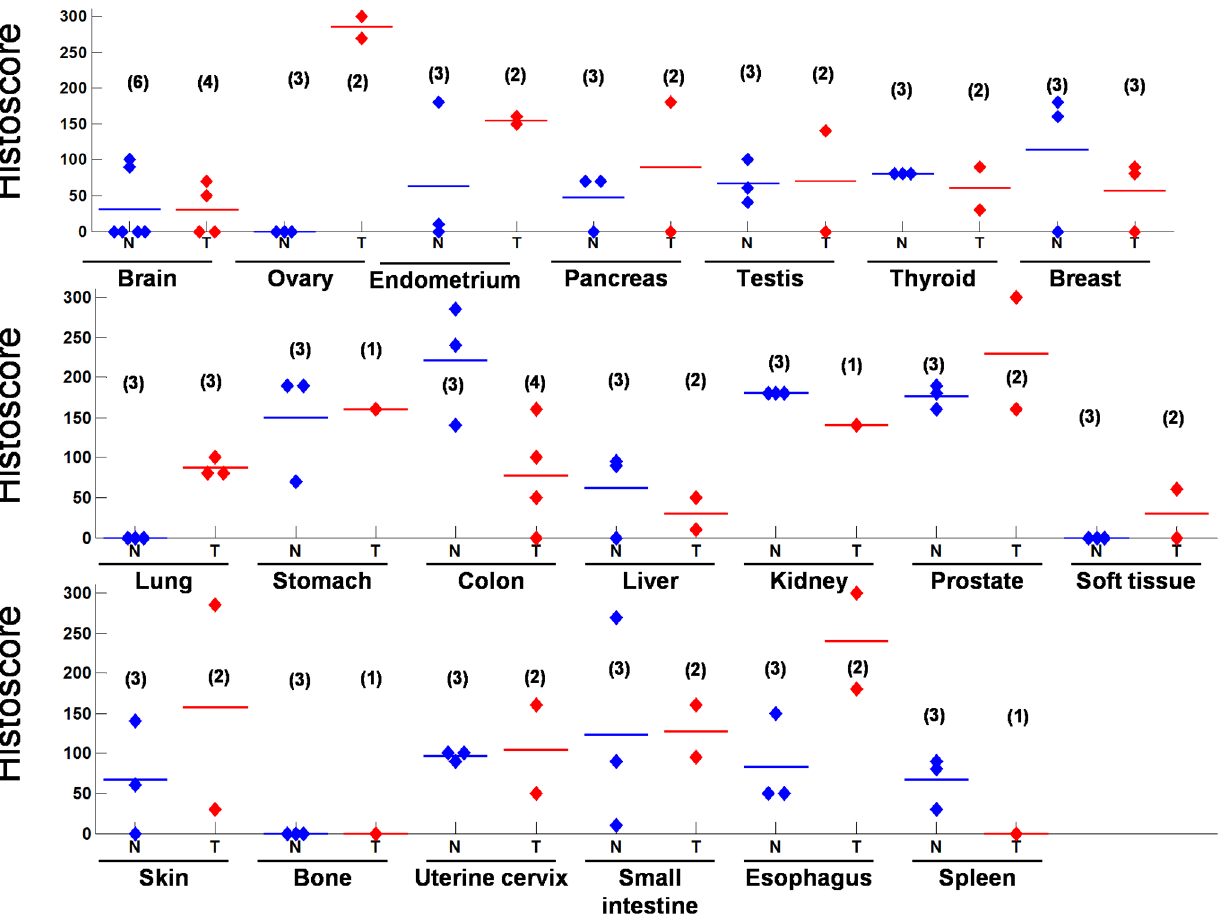
Fig 2. BAIAP2L1 histoscores in multiple human organs and corresponding tumors. Results were derived from commercially available tissue arrays FDA805-1and 805 – 2, containing normal organs and corresponding tumors (S2 Tables). Number in parentheses denotes the number of cases in the tissue arrays. The overall immunohistochemical score (histoscore) was the percentage of positive cells multiplied by its staining intensity (0 = negative, 1 = weak, 2 = moderate, 3 = strong), and ranged from 0 to 300 (100% multiplied by